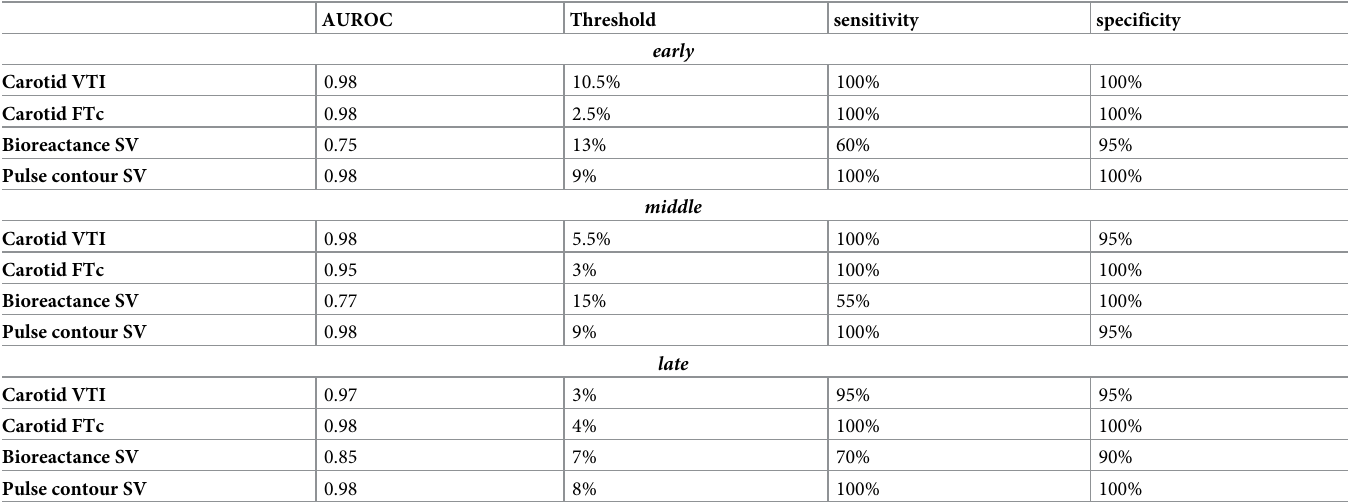
Table 1. Diagnostic accuracy summary